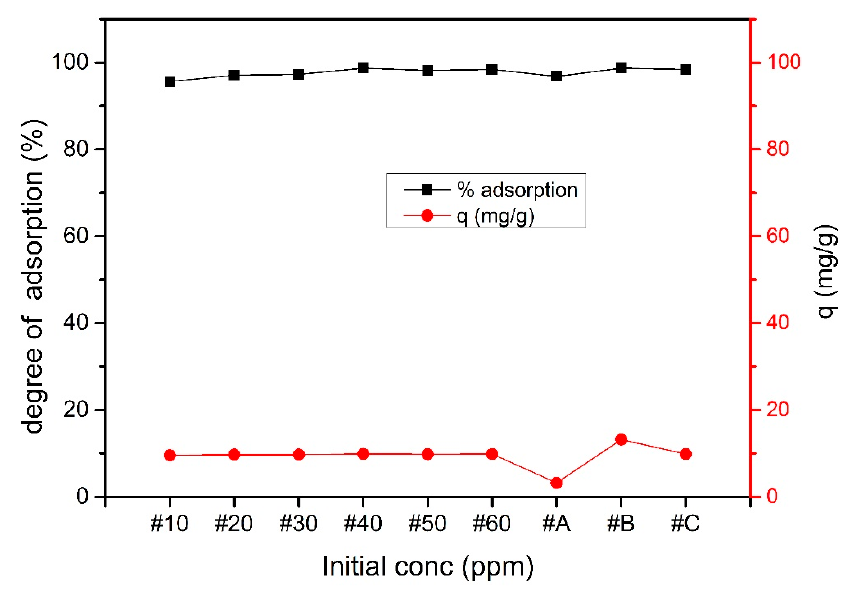
Figure 6. Adsorption performance of BCE hydrogel against single-ion aqueous Bi solutions and binary solutions of: #A = Bi10/Cu40 mg/L; #B = Bi40/Cu10 mg/L; and #C = Bi40/Cu40 mg/L.